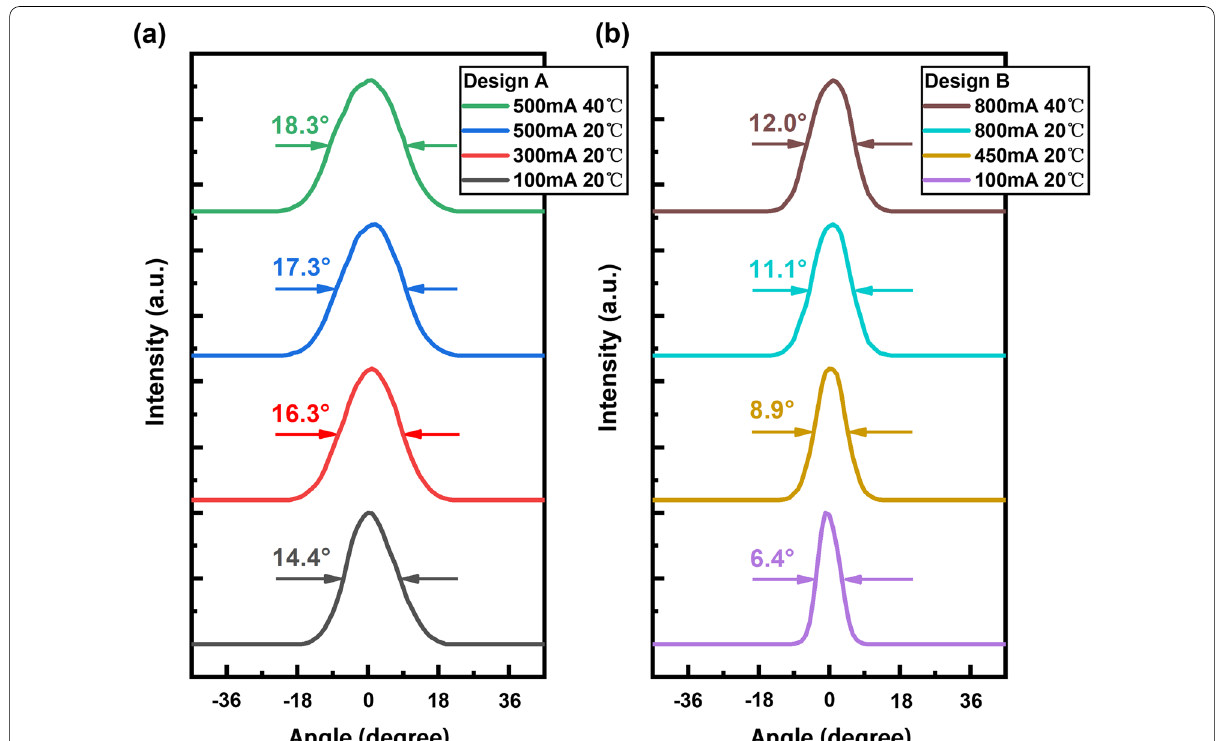
Fig. 5 Lateral far-field intensity distributions of the RW laser designs at different injection currents and heat sink temperatures with corresponding FWHM beam angles indicated: a Design A and b Design